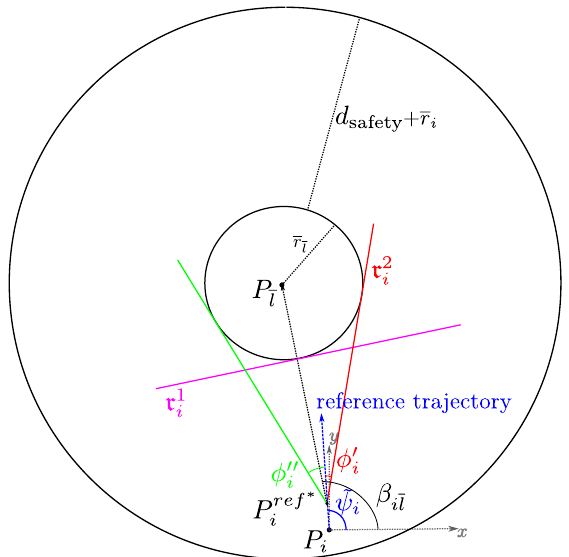
Figure 5. Collision Avoidance constraints (Time information has been omitted). Obstacle is described by circumference centered in the point P j ; tangent lines r 1 i -th future